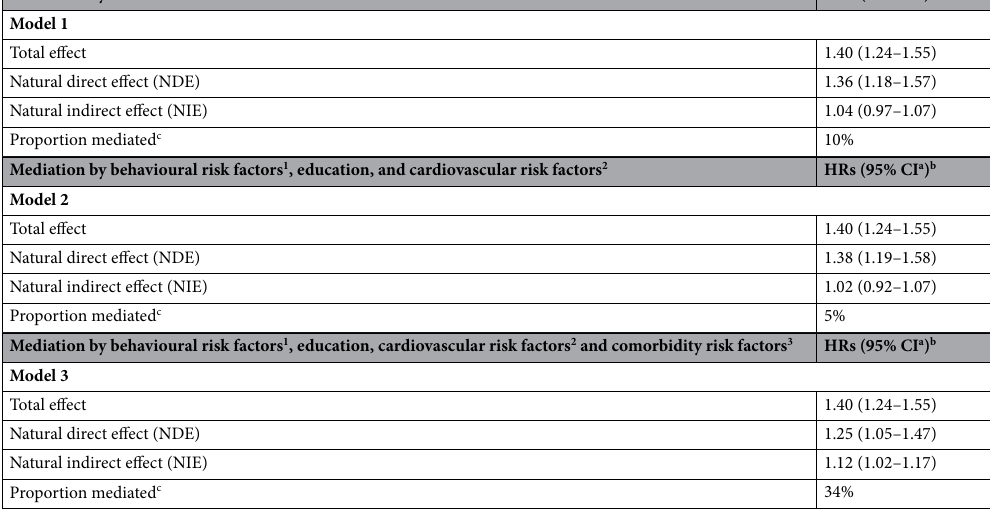
Table 4. Mediation of the associations between sex and BSI by behavioural risk factors, educational attainment, cardiovascular risk factors and comorbidities. BSI bloodstream infection, HRs hazard ratios, 95% CI 95% confidence intervals. 1 Smoking, alcohol use and educational attainment at baseline. 2 Systolic blood pressure, non-high-density lipoprotein cholesterol and Body Mass Index. 3 Cardiovascular disease, chronic kidney disease, diabetes, history of cancer, or chronic lung disease. a Percentile-based bootstrap CIs are reported. b Estimates are adjusted for age as a covariate. c Proportion mediated: (ln HR NIE /ln HR TOTAL